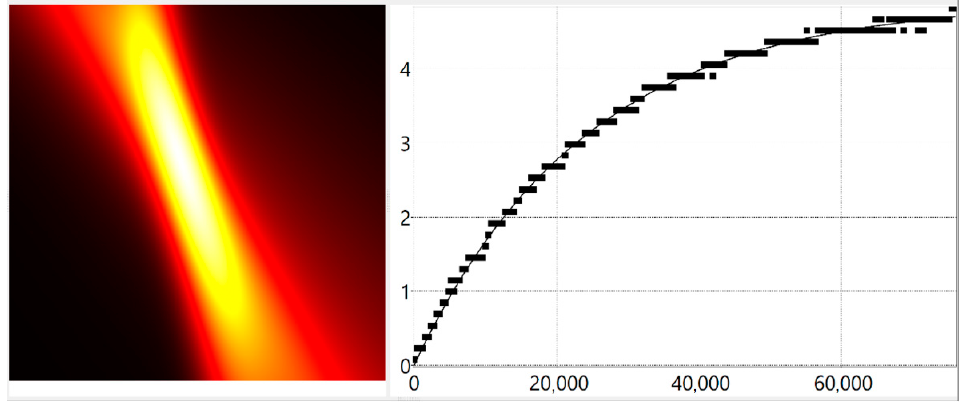
Figure 6. Results of the analysis of a sample of data describing the transient process in the RC chain.